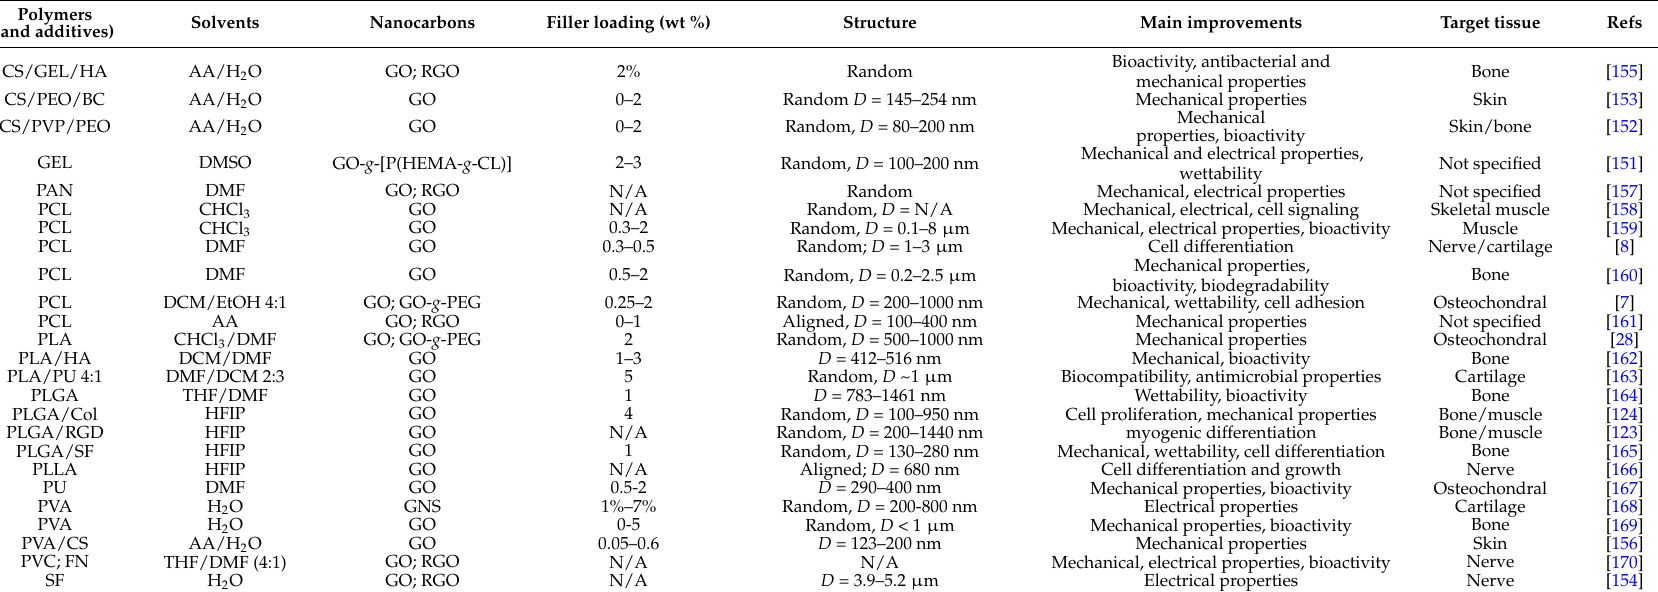
Table 3. Examples of polymer-graphene electrospun scaffolds for tissue